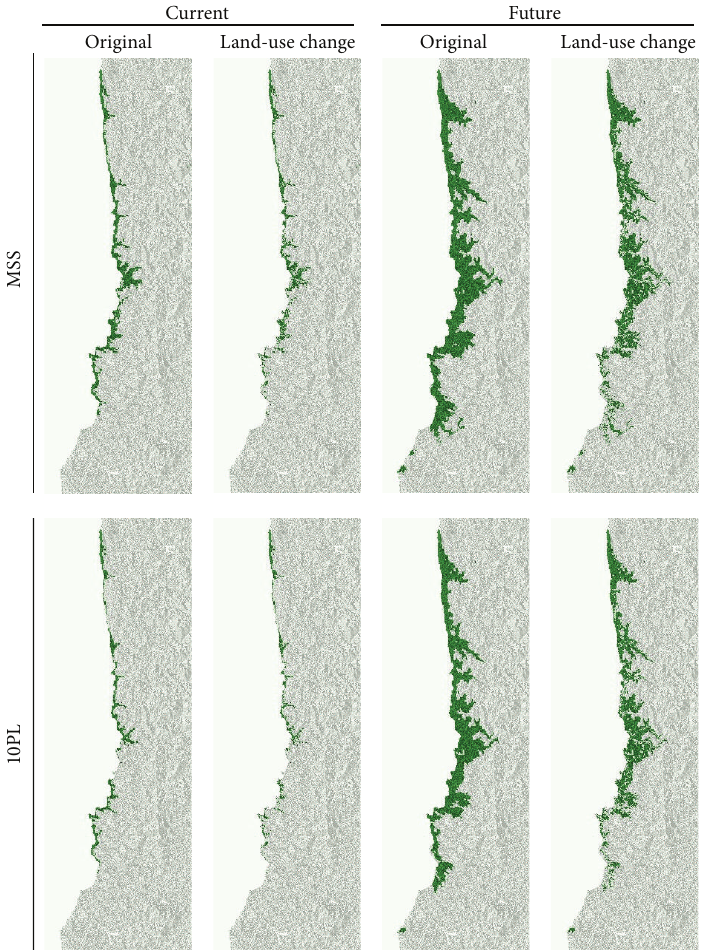
Figure 2: Binary maps showing potential habitat (green) of P. splendens with or without land-use change under current climate (years 1950 to 2000) and under future climate change scenario (RCP 6.0) (years 2041 to 2060). Two different thresholds were used to generate the binary maps, maximum sensitivity plus specificity (MSS) and 10 percentile training presence